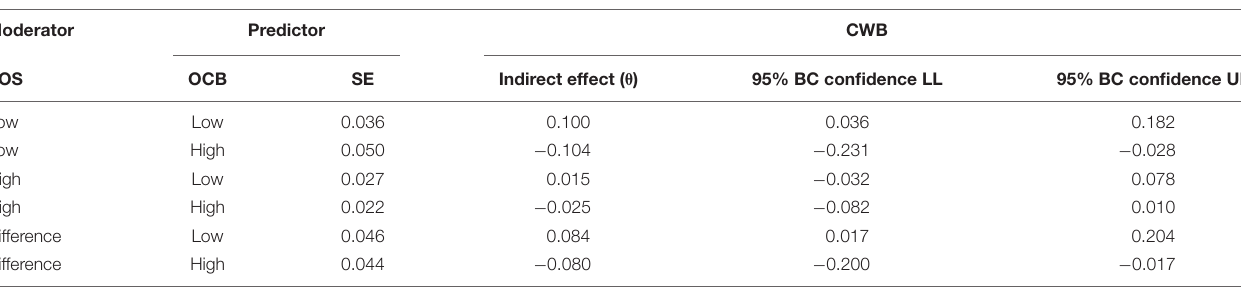
TABLE 4 | The conditional indirect effect of OCB on CWB through citizenship